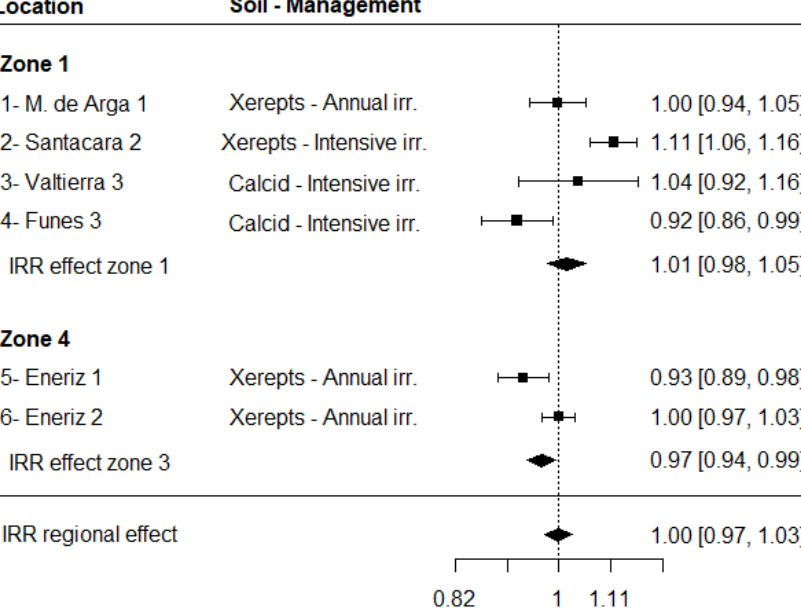
Figure 10. Response ratio (RR) of BD (0–30 cm) for the adaptive management strategy of con- trolled grazing and/or rotation in grasslands (GSS). Zones correspond to those in Figure 1. The effect was considered significant when the 95% confidence interval (CI) of the RR did not overlap one ( α = 0.05). Soil and management column includes information about principal soil group and management considered in each group. The strategy of CA was evaluated in 10 groups through the region. The effect of per- manent grass cover in permanent crops was evaluated in three groups, where two of them showed a neutral effect and one a negative effect (Figure 6). In the rest of groups where